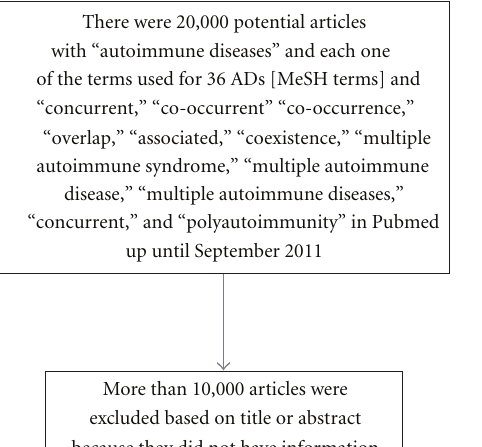
The prevalence of polyautoimmunity was significantly dif- ferent among the four ADs, being less frequent in MS (Table